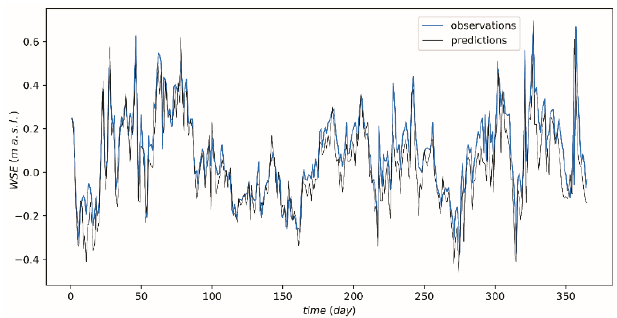
Figure 10. Observed (black) and calculated (blue) water level (WSE) variation at Tolkmicko in 2008.